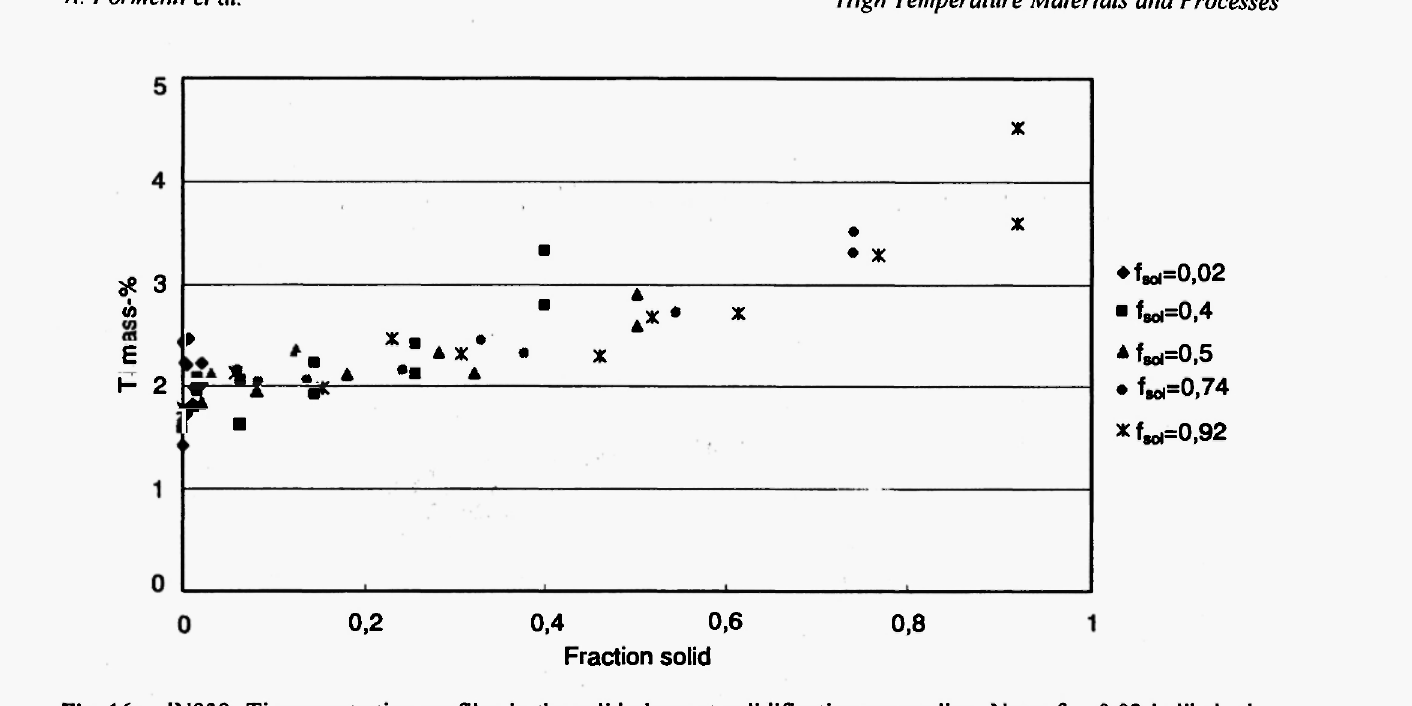
IN939. Ti concentration profiles in the solid phase at solidification proceeding. Note: ^ = 0 . 02 is likely the concentration in the liquid phase. Extraction rate v^lOOlO" 6 m/s.